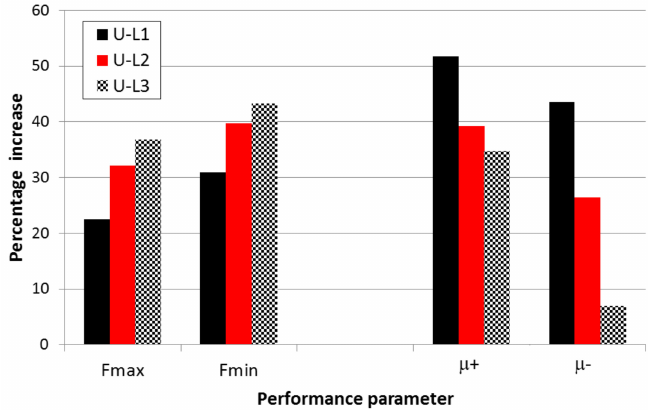
Figure 7. Increases in strength and ductility of the different